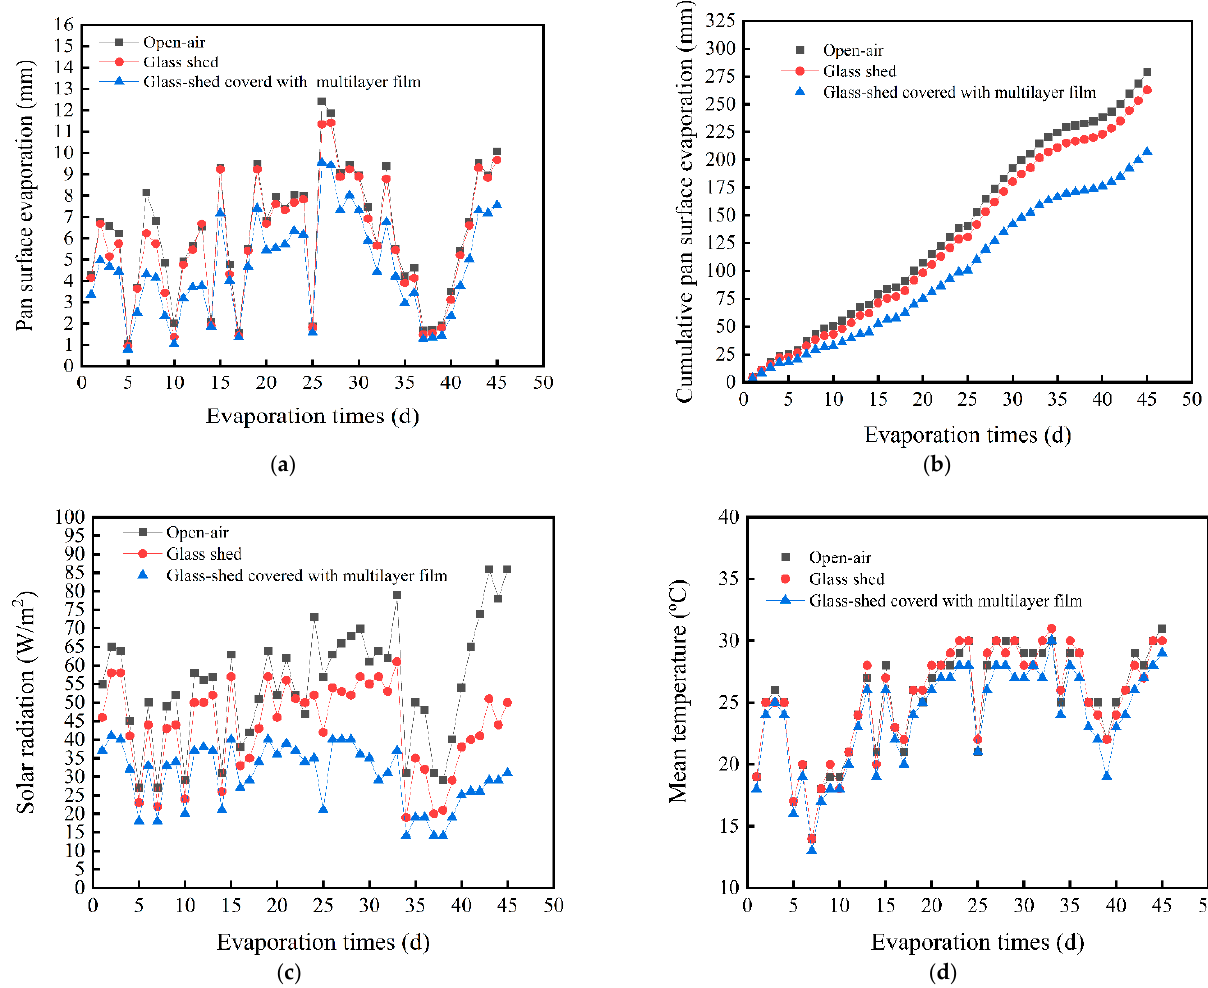
Figure 6. The effect of three treatments on the evaporation of water from the surface of the pan ( a ) pan surface evaporation (mm) ( b ), cumulative pan surface evaporation (mm), ( c ) solar radiation (W/m 2 ), and ( d ) mean temperature (°C).